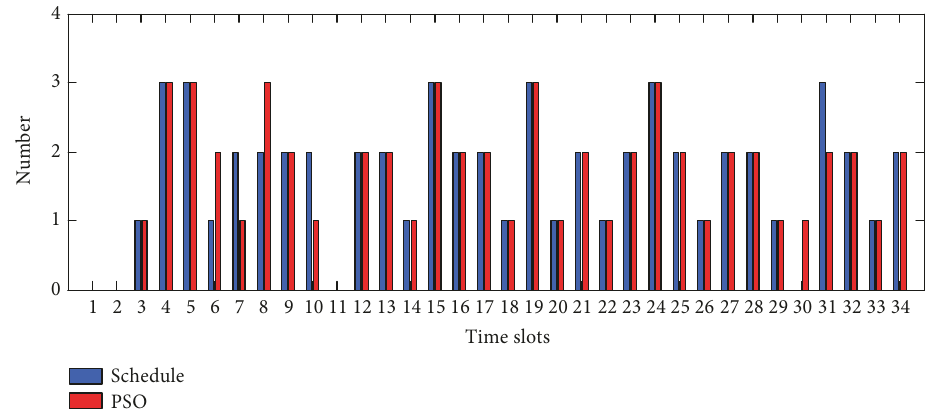
Figure 7: The number of batteries swapped using the schedule and PSO strategies.